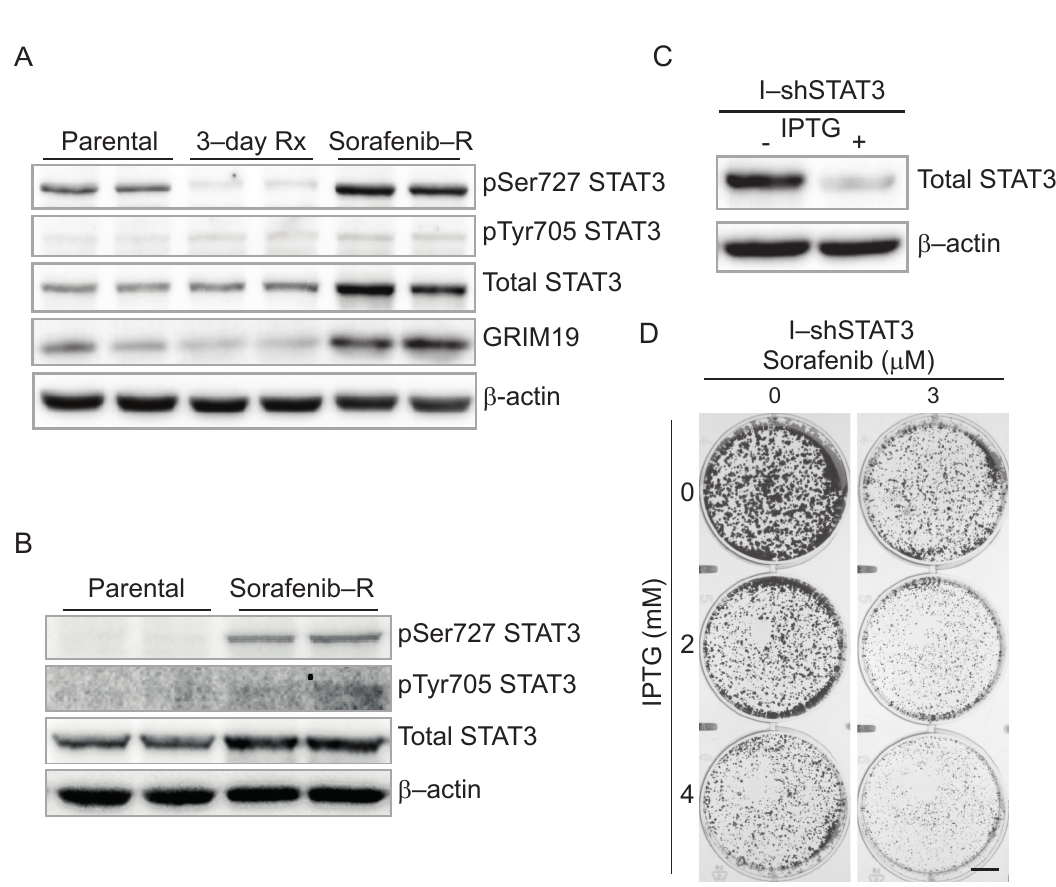
Figure 4. pSer727 STAT3 activation in sorafenib-resistant Huh7 cells. ( A ) Total and phosphorylated STAT3 and GRIM19 levels in parental, sorafenib-treated (3-day Rx) and sorafenib-resistant (sorafenib-R) Huh7 cells determined by western blot. B-actin is a protein loading control. ( B ) Total and phosphorylated STAT3 in parental and sorafenib-resistant Huh7 colonies isolated by 3-week exposure to sorafenib. ( C ) Inducible STAT3 knockdown in sorafenib-resistant Huh7 cells expressing IPTG-inducible short hairpin RNA (shRNA) targeting STAT3 (I-shSTAT3). ( D ) Growth of sorafenib-resistant Huh7 cells exposed to sorafenib with and without induction of STAT3 knockdown by IPTG in clonal growth conditions. Bar: 10